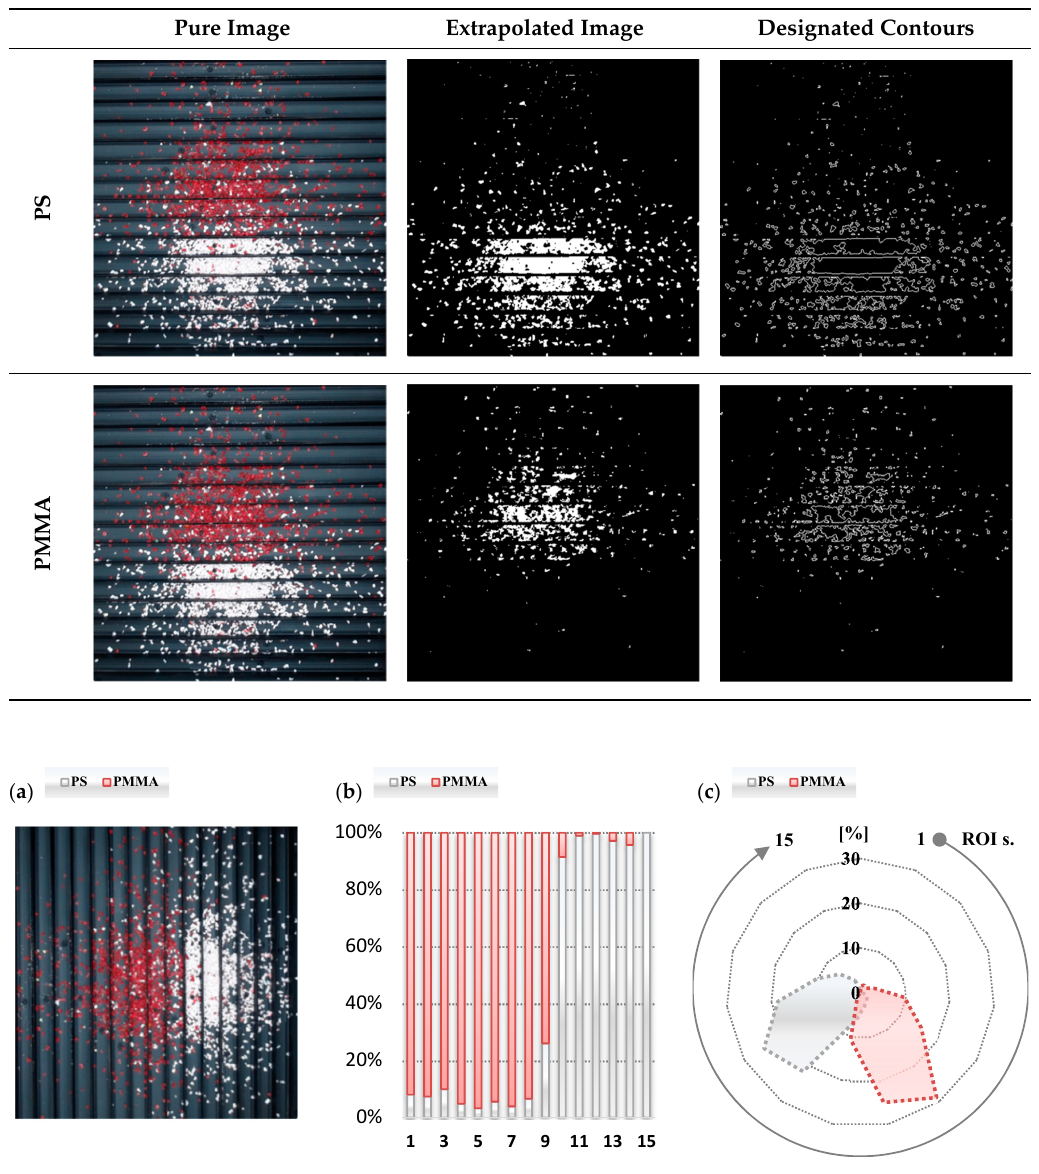
Table 4. Tests with separator—tribocharging mode.